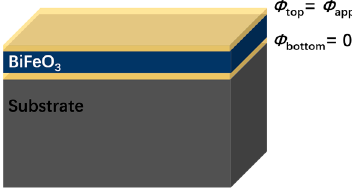
Figure 1. Schematic illustration of the ferroelectric BiFeO 3 (BFO) thin film model.